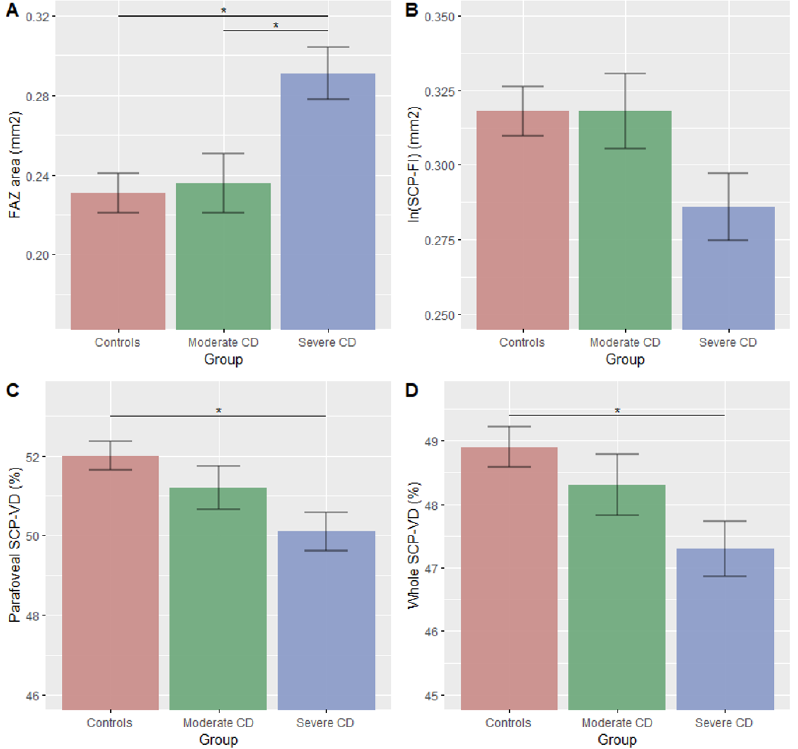
Figure 3. Age- and sex-adjusted ANCOVA, significant microvascular macular features according to Crohn’s disease severity. ( A ) FAZ area, p -value post-hoc ANCOVA: controls vs. moderate CD, 0.01; controls vs. severe CD, 0.001; ( B ) ln (SCP-FI), p -value post-hoc ANCOVA: controls vs. moderate CD, 0.08; moderate vs. severe CD, 0.08; ( C ) Parafoveal SCP-VD, p -value post-hoc ANCOVA: controls vs. severe CD, 0.009; ( D ) Whole SCP-VD, p -value post-hoc ANCOVA: controls vs. severe CD,